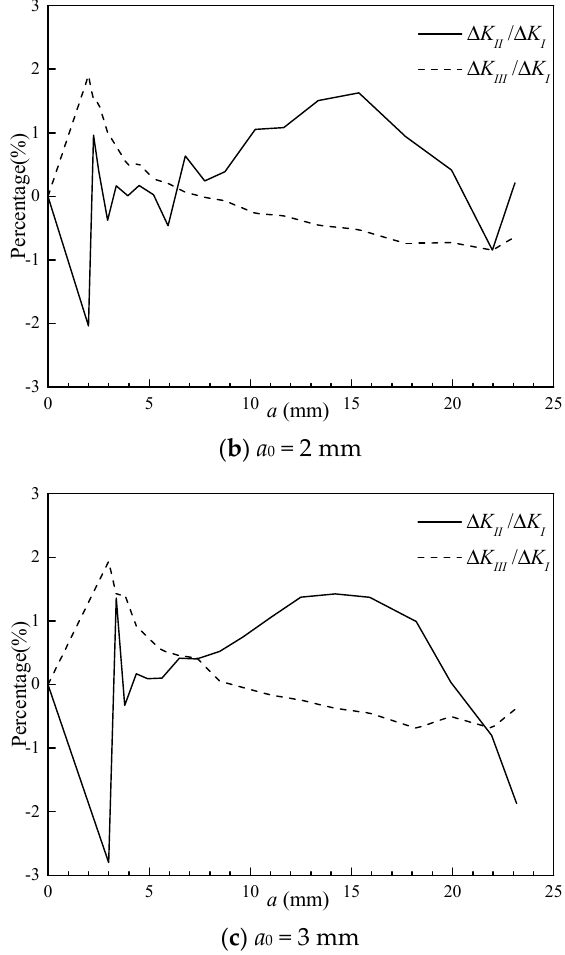
∆ K ∆ K II , III , and I at crack front.